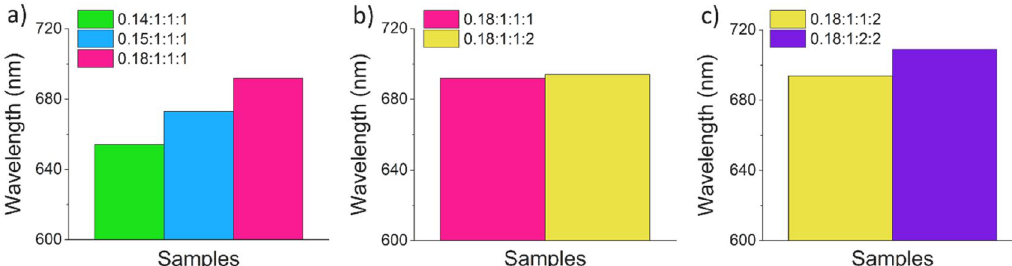
Figure 4. PL maximum wavelength of AIS/ZnS QDs synthesized with the capping agent GSH (0.5 M) using different ratios of Ag:In:S:Zn. ( a ) Variation of the Ag(I) amount (Ag:In:S:Zn), ( b ) variation of the Zn(II)